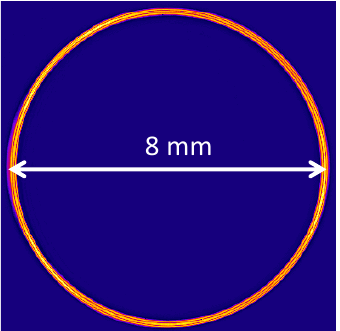
Fig. 4. Image of the beam profile at 150W in the sample plane obtained with a high power laser beam profiler.